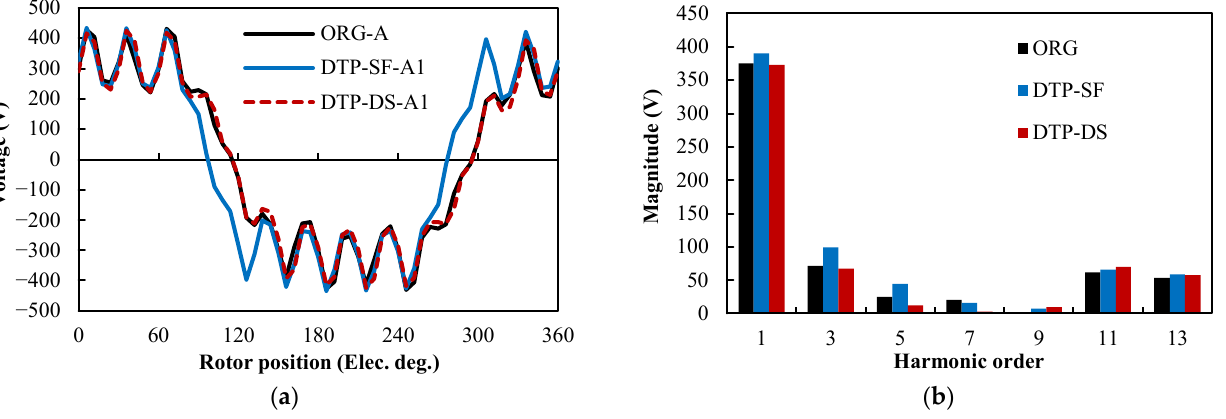
Figure 22. Phase back EMFs of different winding configurations @ I A = 236 Apk, β = 0°: ( a ) waveforms; ( b ) spectra.